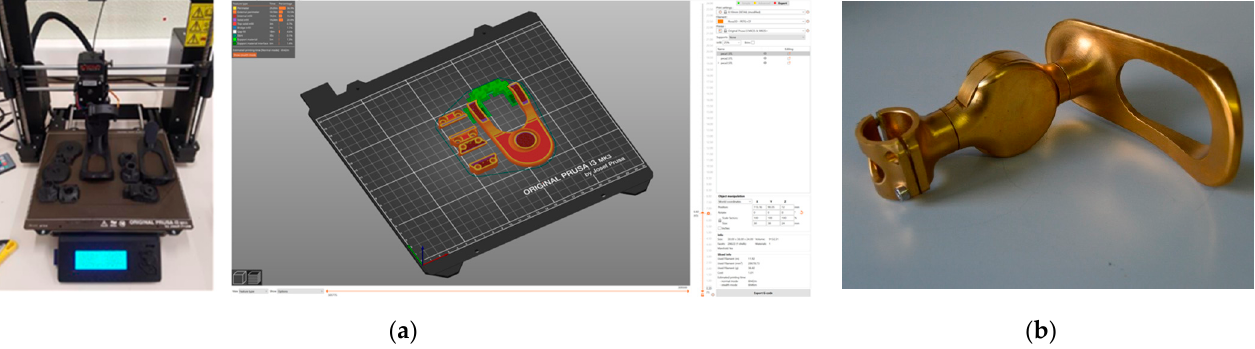
Figure 8. ( a ) Visualization of 3D printing in PETG-CF material; ( b ) brass prototype produced with CNC machining.